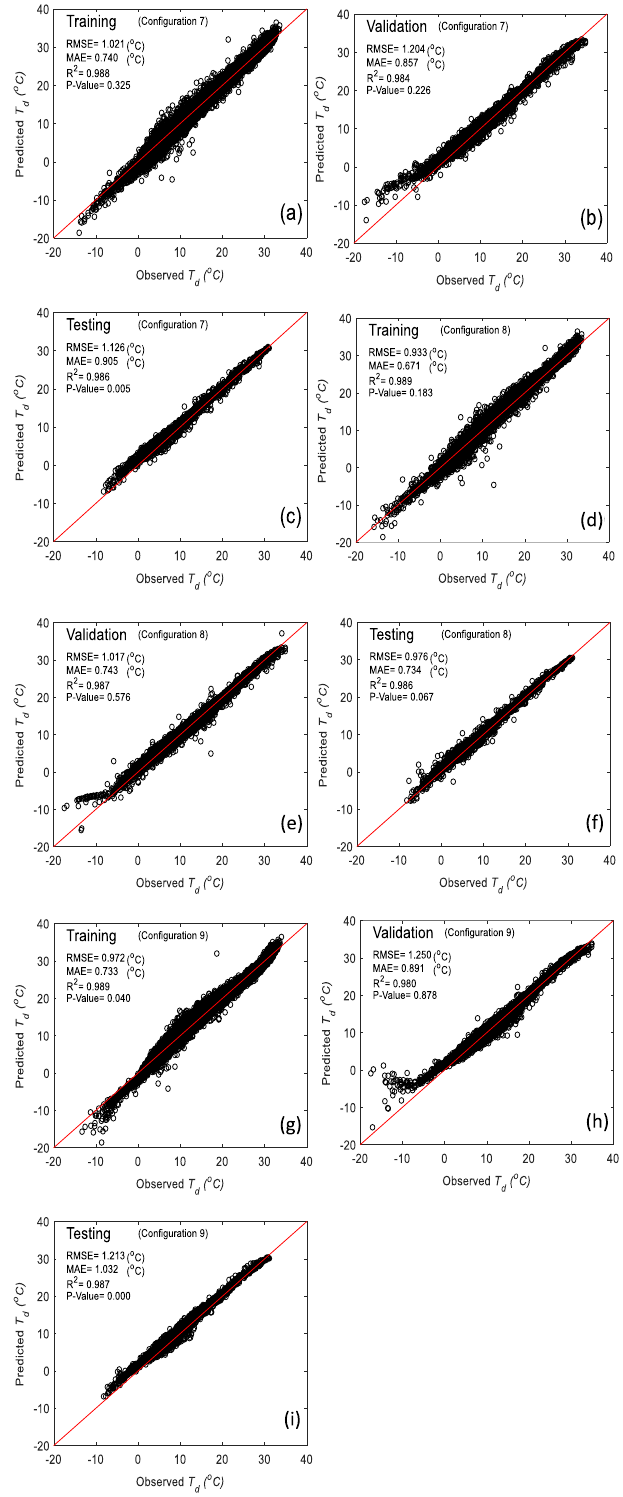
Fig. 11 Scatter plot of training, testing, validation steps, and all data for scenario